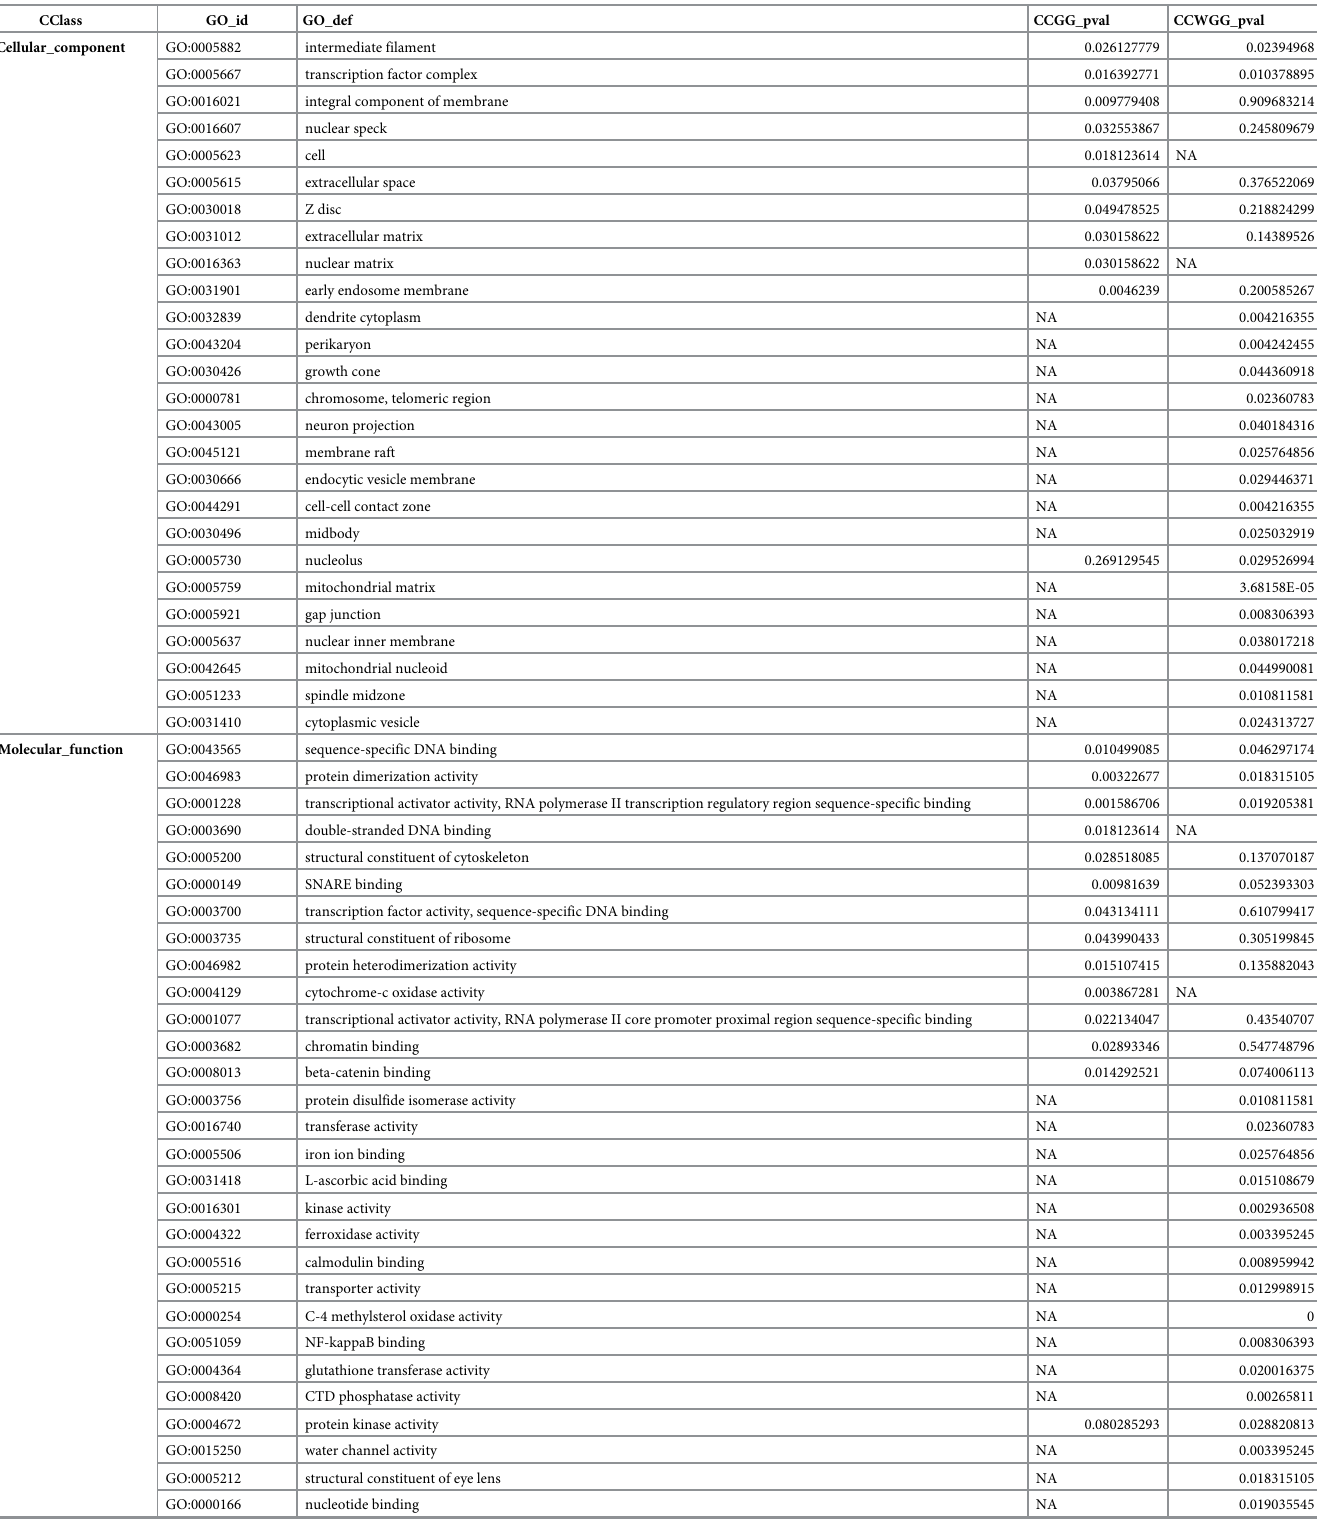
Table 5. GO enrichment of genes related to different methylation